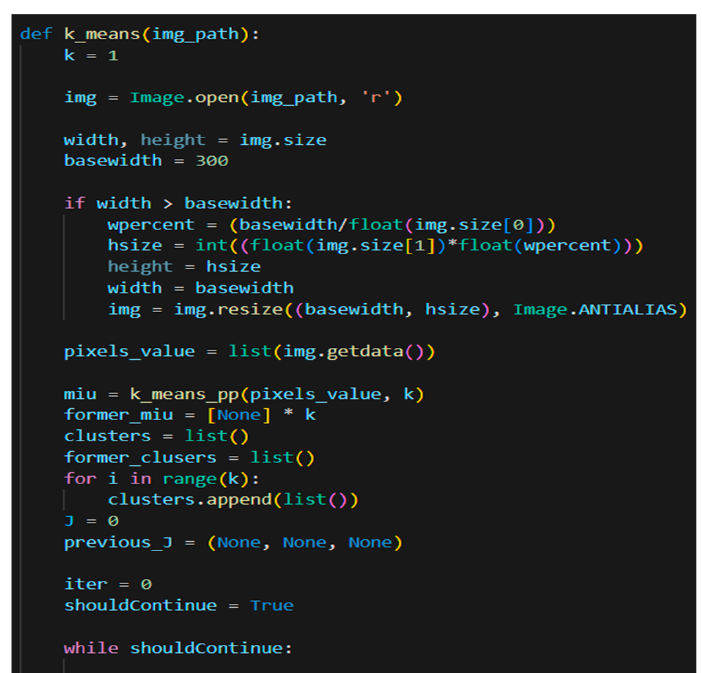
Figure 13. K Means Class.